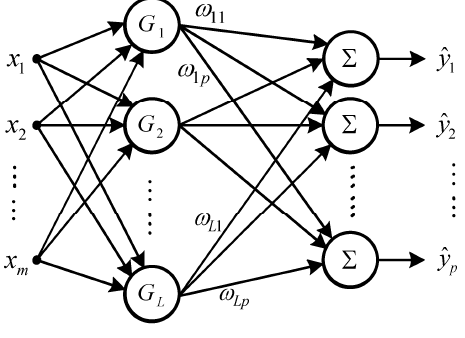
Figure 1. The structure of RBFNN.